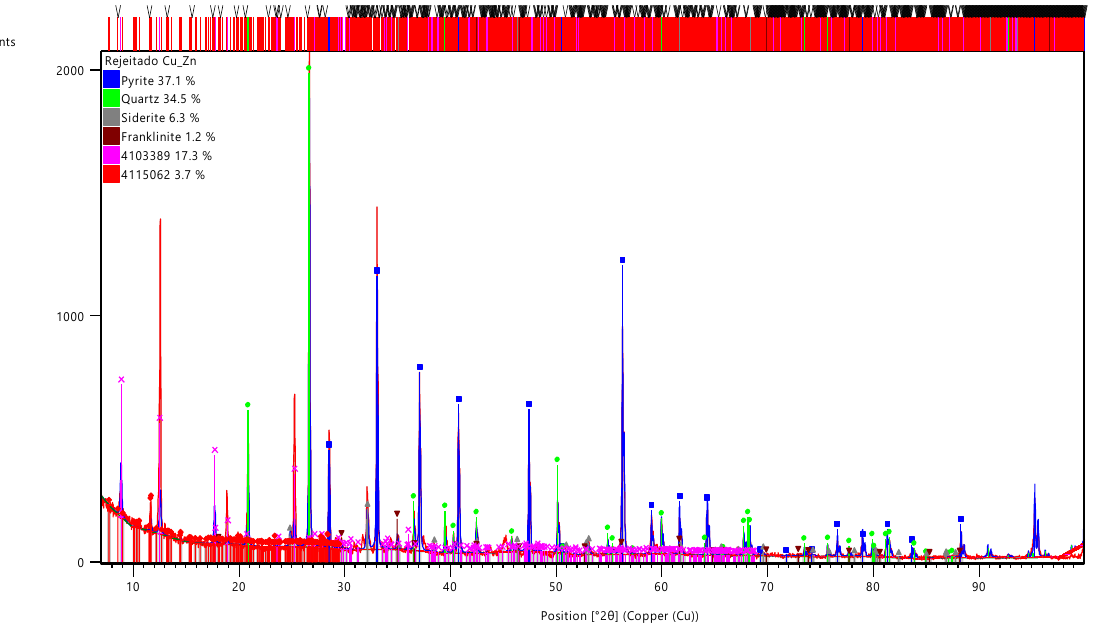
Figure 3. Mineralogical composition of the mine tailing obtained by XRD.